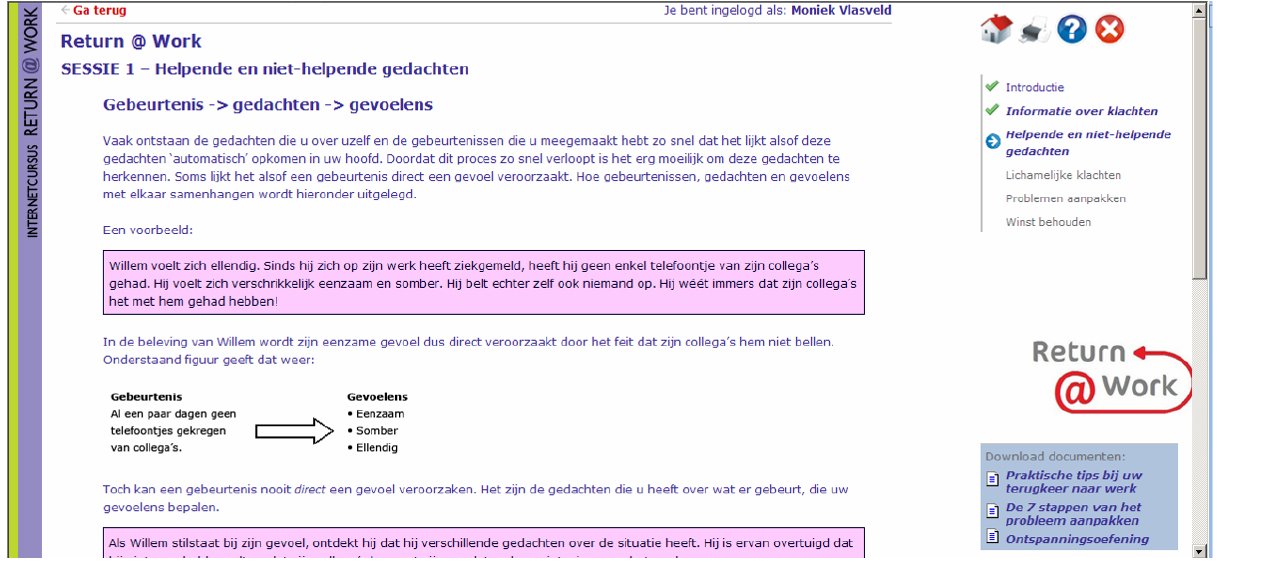
Figure 2. Screenshot of